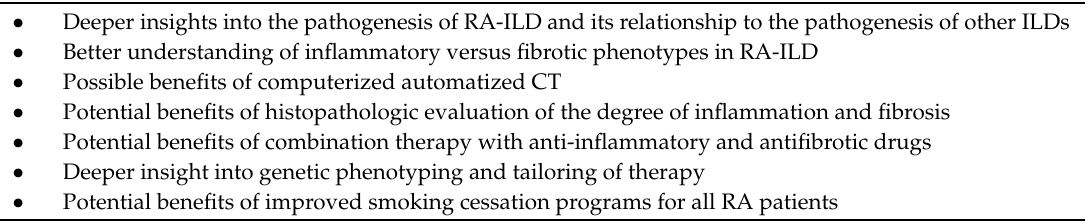
Table 5. Future research needs in